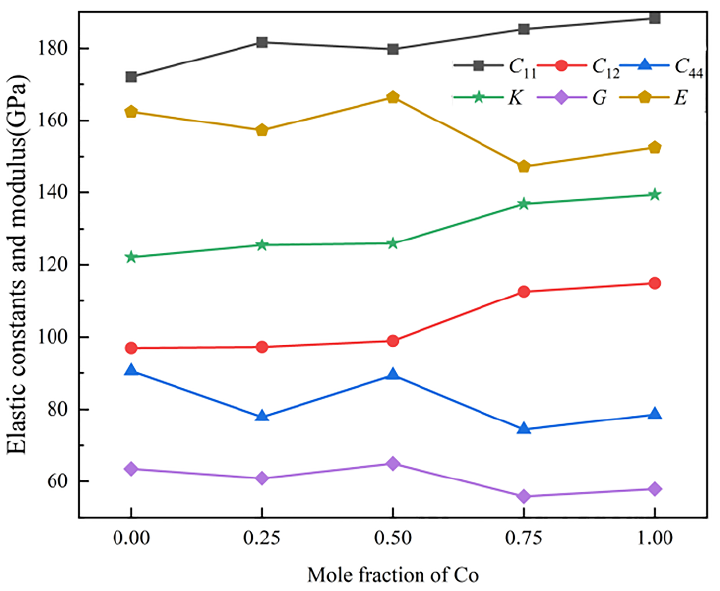
Figure 2. The elastic constants ( C 11 , C 12 , C 44 ) and modulus ( K , G , E ) of AlCo x CrFeNi (x = 0, 0.25, 0.5, 0.75, 1) HEAs.